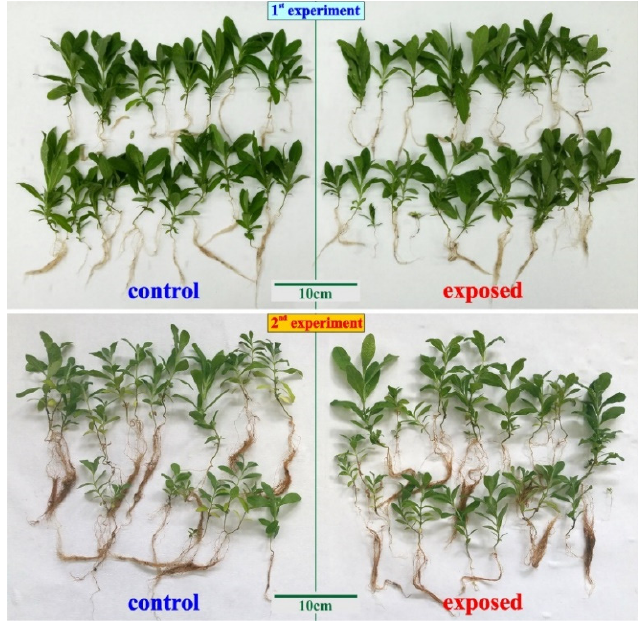
Figure 2. The two groups of cultured, fresh individuals of C. creticus . Primarily, the differences in biomass.